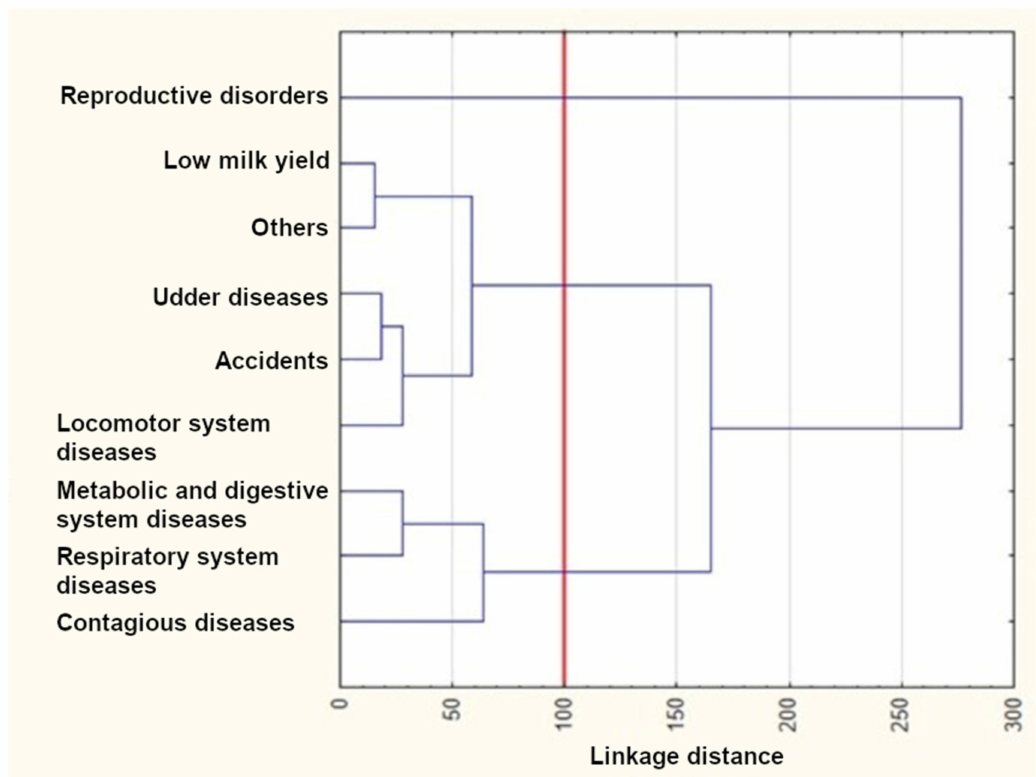
Figure 5. The results of the cluster analysis using Ward’s method for the first and second lactations.